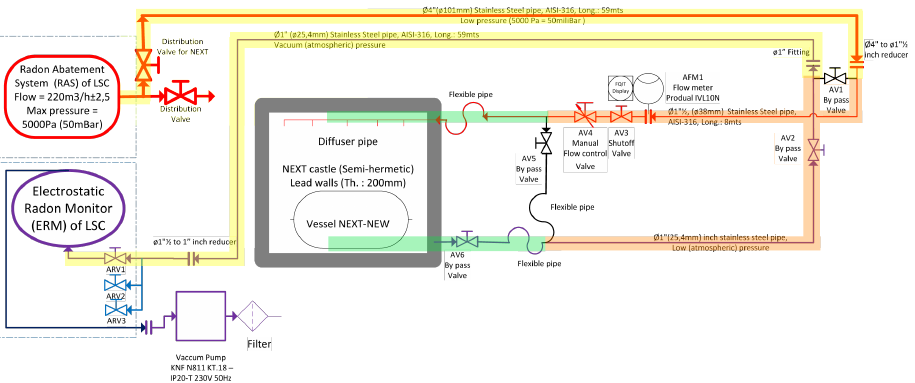
Figure 16. Paths used for the three different measurements of Rn